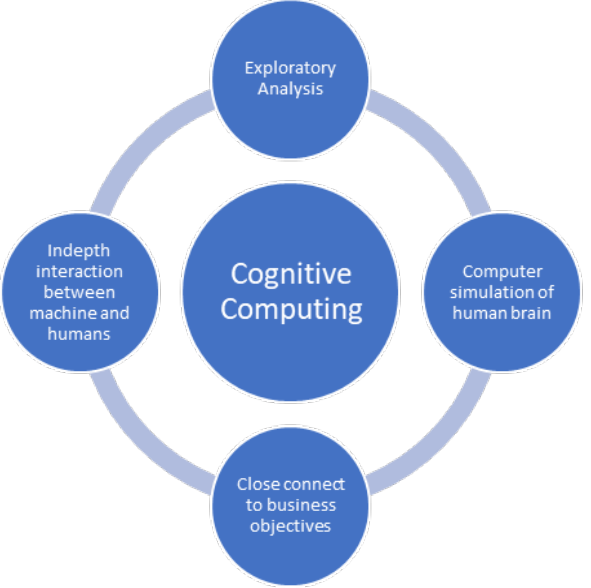
Figure 1. Pictorial representation of Cognitive Computing and its objectives